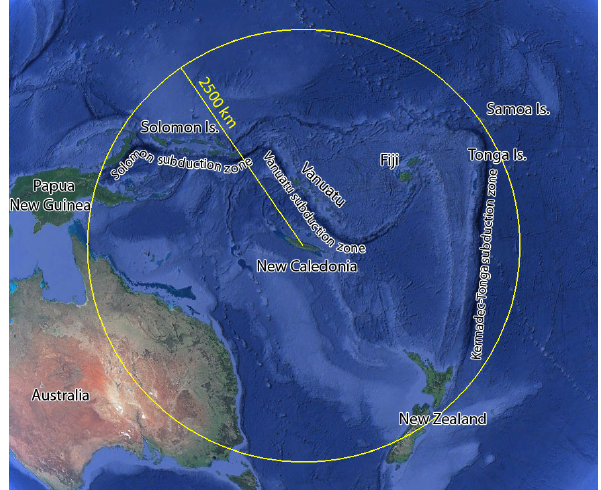
Figure 3. 2500km around New Caledonia (credit: © Google 2018, Landsat/Copernicus image).